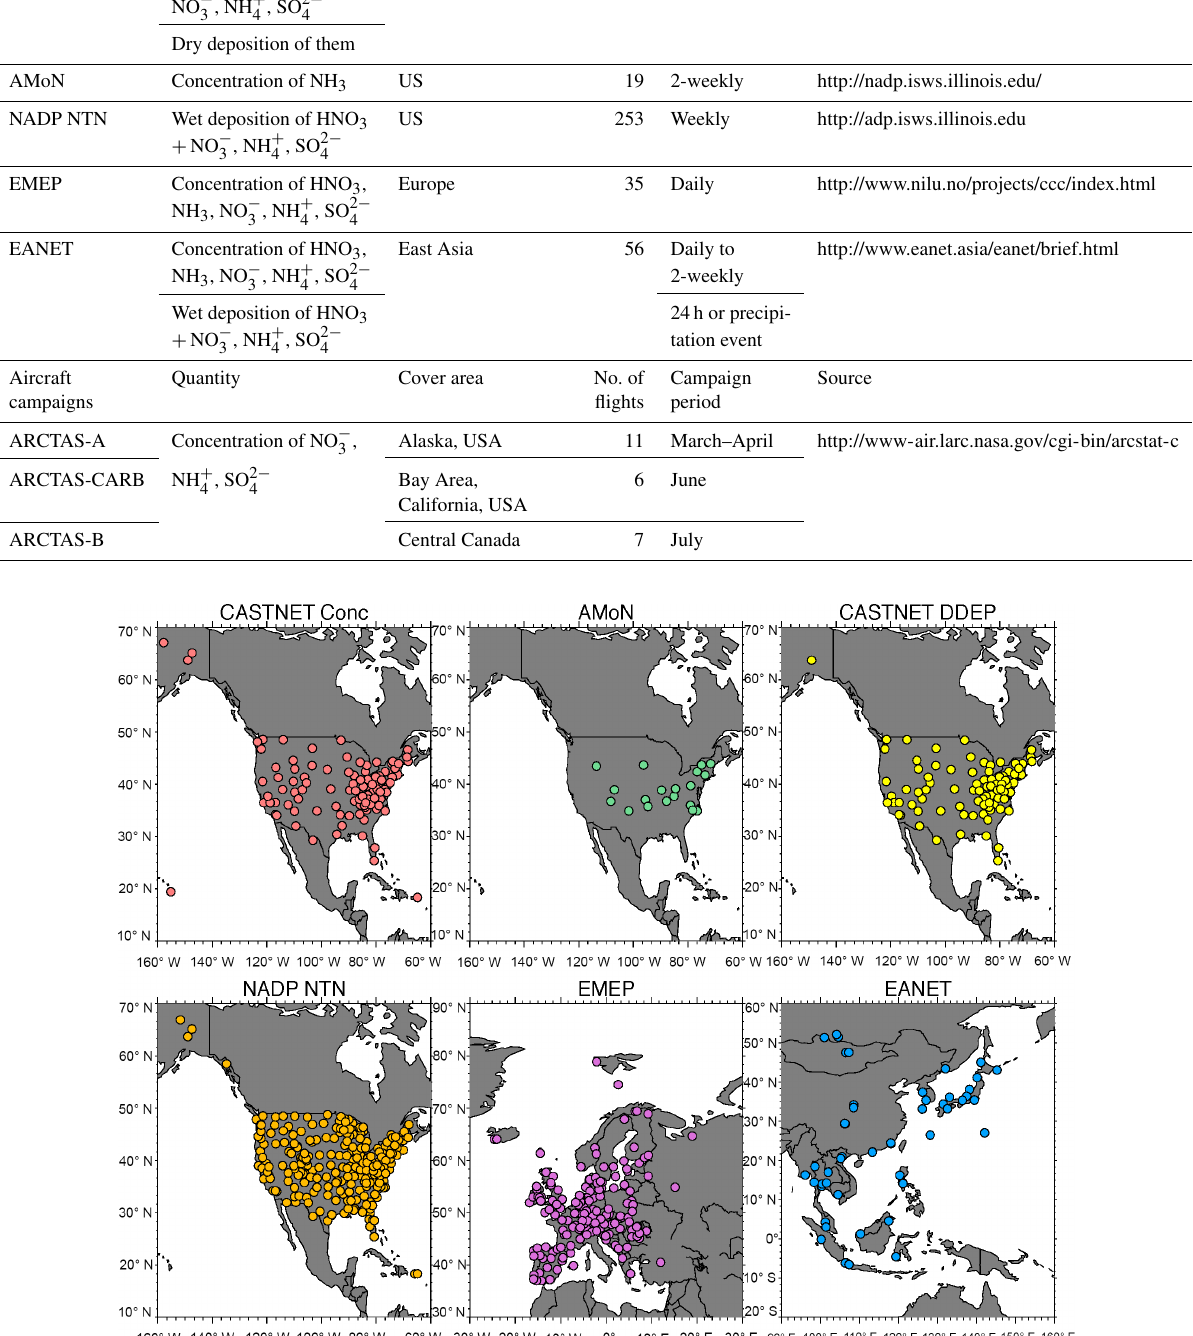
Figure 1. The observational station locations for CASTNET surface concentrations (CASTNET Conc), Ammonia Monitoring Network (AMoN) over the US, CASTNET dry deposition (CASTNET DDep), National Atmospheric Deposition Program – National Trends Network (NADP NTN) for wet deposition over the US, surface concentrations over Europe (EMEP), and surface dry and wet deposition over Asia